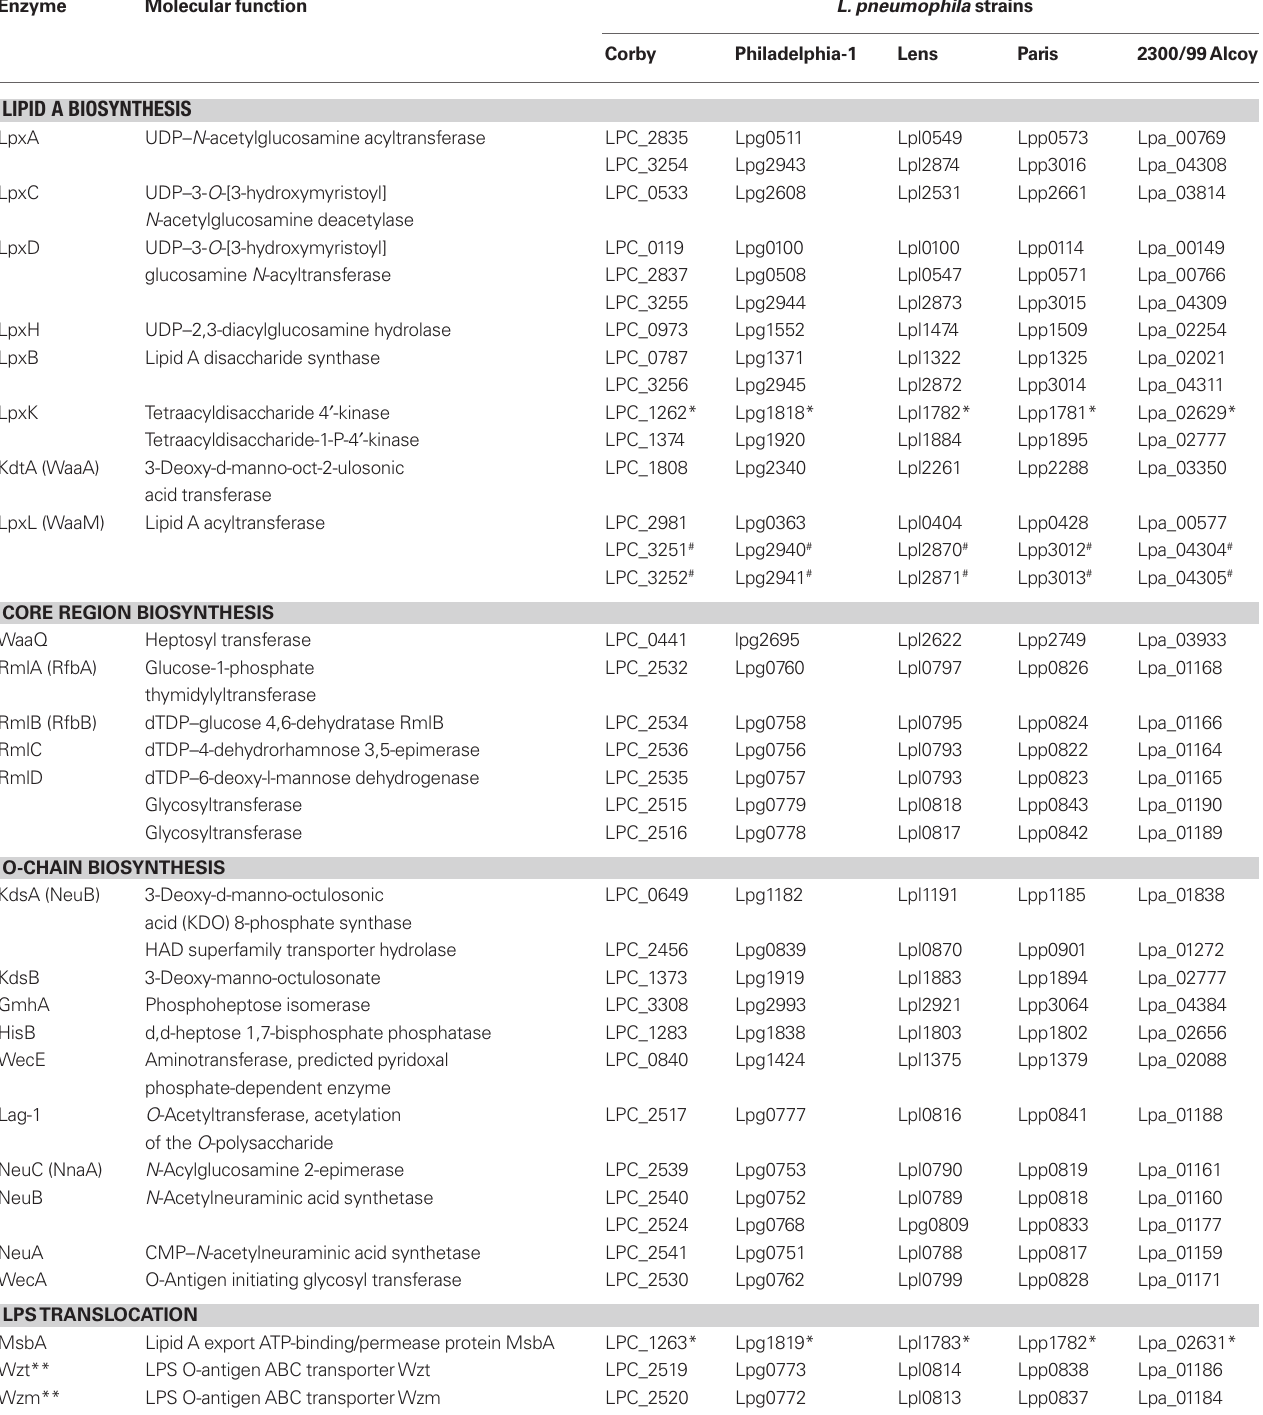
Table 4 | Paralogs of LPS biosynthesis and translocation proteins in L. pneumophila strains. enzyme Molecular